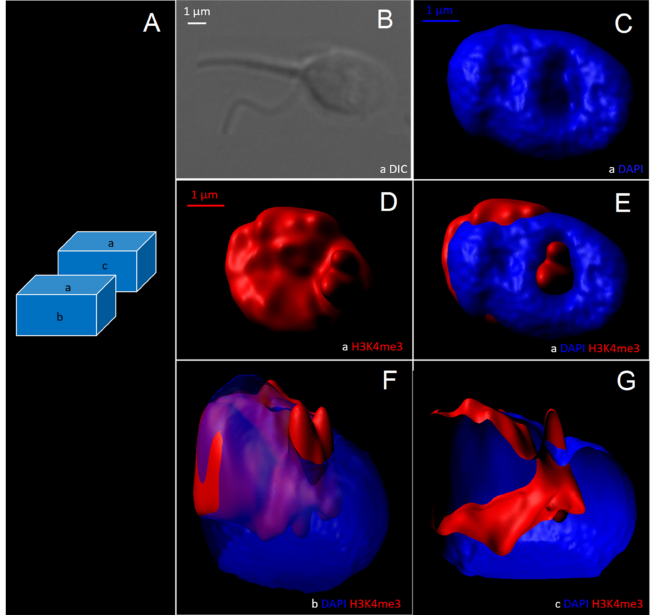
Figure 8. Three-dimensional reconstruction by optical sectional microscopy and deconvolution of a morphometrically normal spermatozoon with one vacuole (occupying more than 15% of head surface), tagged for H3K4me3. ( A ) Schematic of the upper plane (a), frontal plane (b), and a cross-section (c) of the spermatozoon. ( B ) The spermatozoon visualized with differential interference contrast (DIC). Three-dimensional reconstructed images of the spermatozoon with ( C ) DAPI labelling, ( D ) H3K4me3 labelling, and ( E – G ) DAPI/H3K4me3 labelling. DAPI: 4 (cid:48)